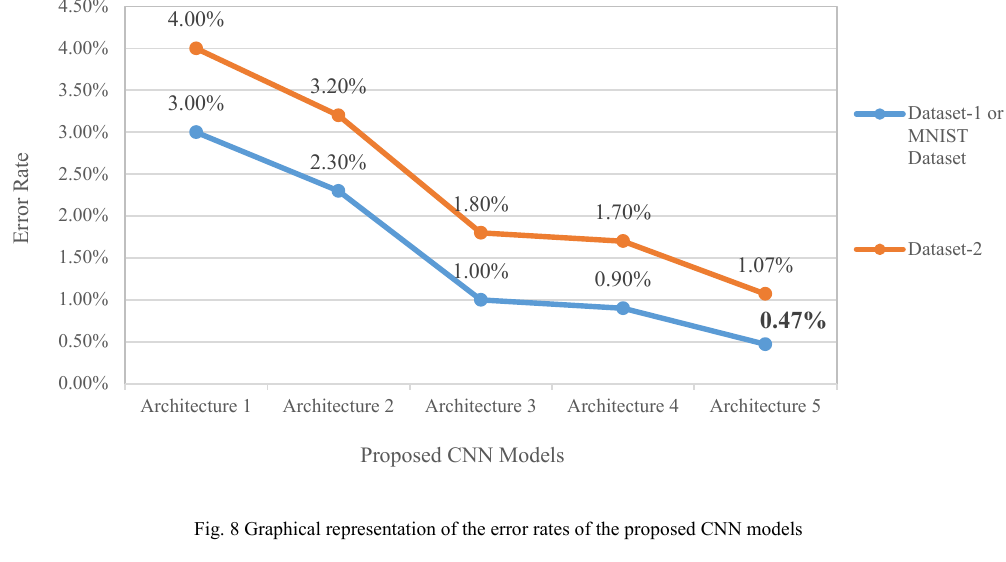
Fig. 8 Graphical representation of the error rates of the proposed CNN models